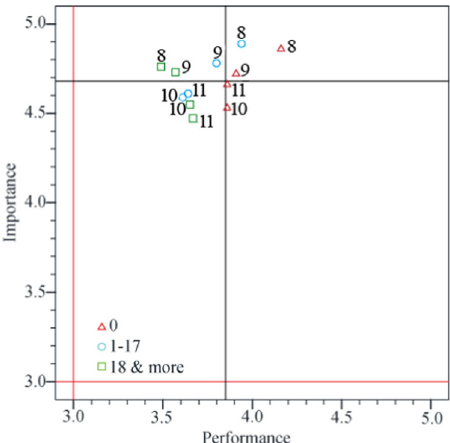
Fig. 5 IPA values of “ challenges when implementing STEM-ED ” in the different number of weekly teaching hours. All four green squares (representing teachers who taught ≥ 18 h per week) were on the mean score line ’ s lower score side.